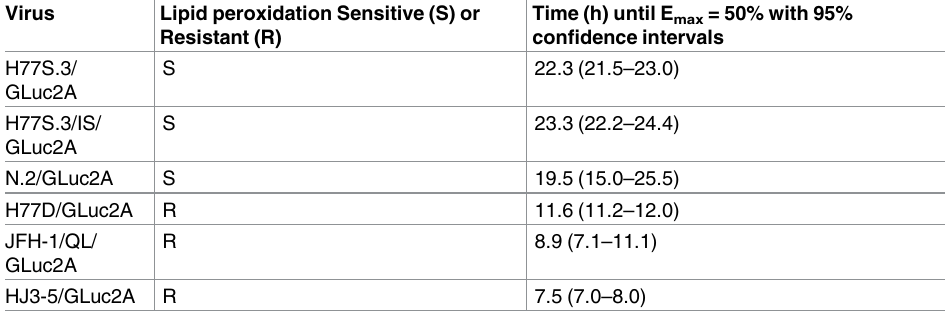
Table 1. Time until E max = 50% for lipid peroxidation sensitive and resistant HCV clones, measuredby GLuc assay.